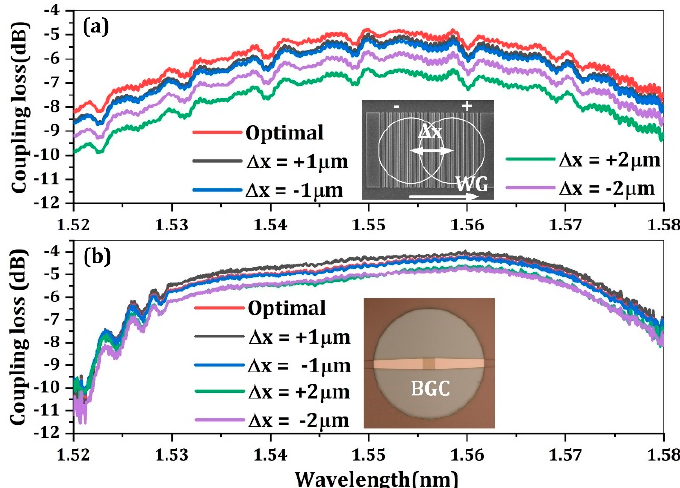
Figure 6. ( a ) The coupling efficiency spectra with waveguide-direction fiber misalignment for a conventional GC. ( b ) The coupling efficiency spectra with waveguide-direction fiber misalignment for a bidirectional GC.